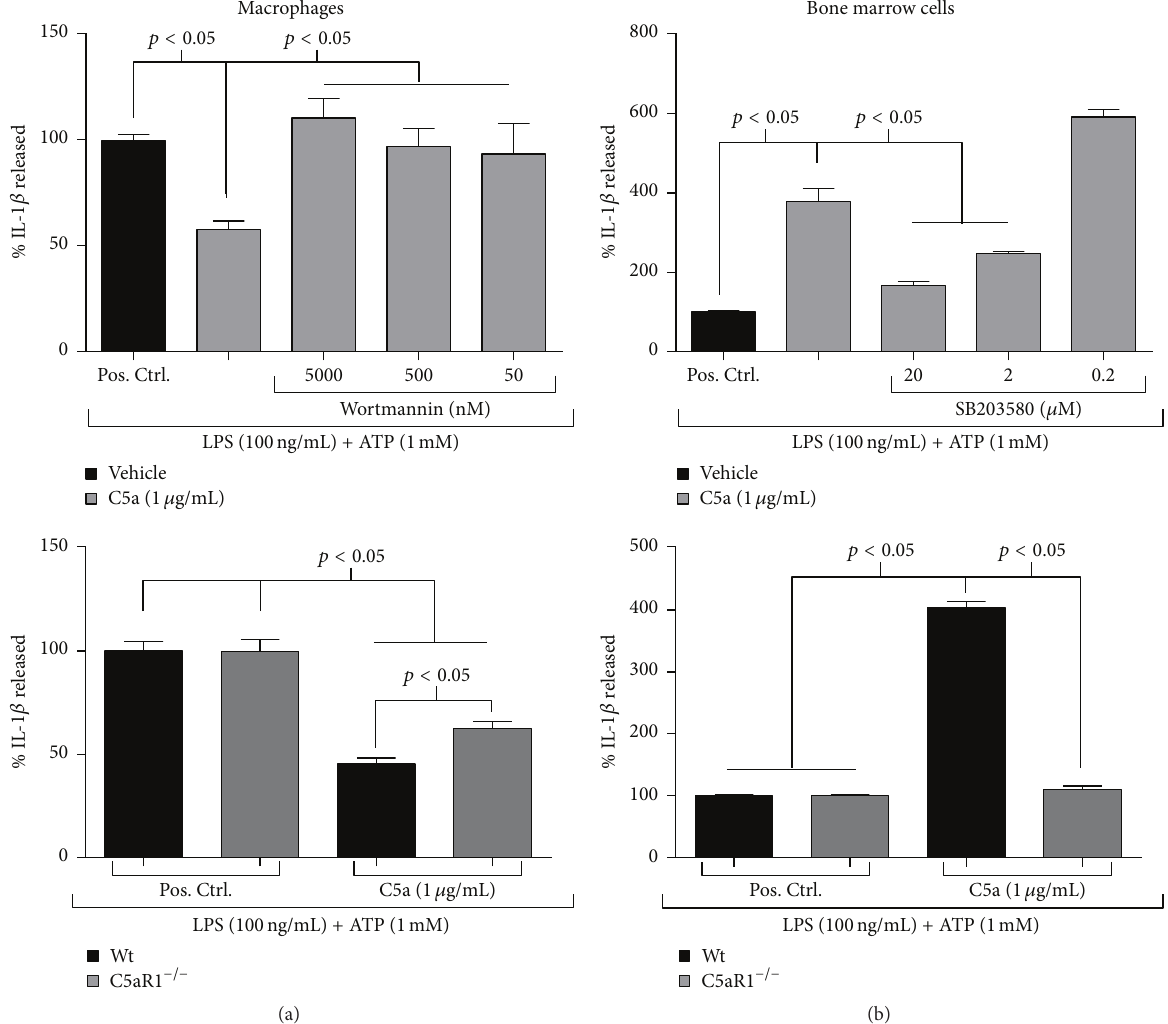
Figure 4: C5a augments LPS-primed IL-1 𝛽 production in bone marrow cells via C5aR1 and p38 signaling but suppresses the NLRP3 pathway inmacrophagesthroughPI3KwithlimiteddependencyonC5aR1.Forsignalinginhibitionstudies(toppanels), 1×10 6